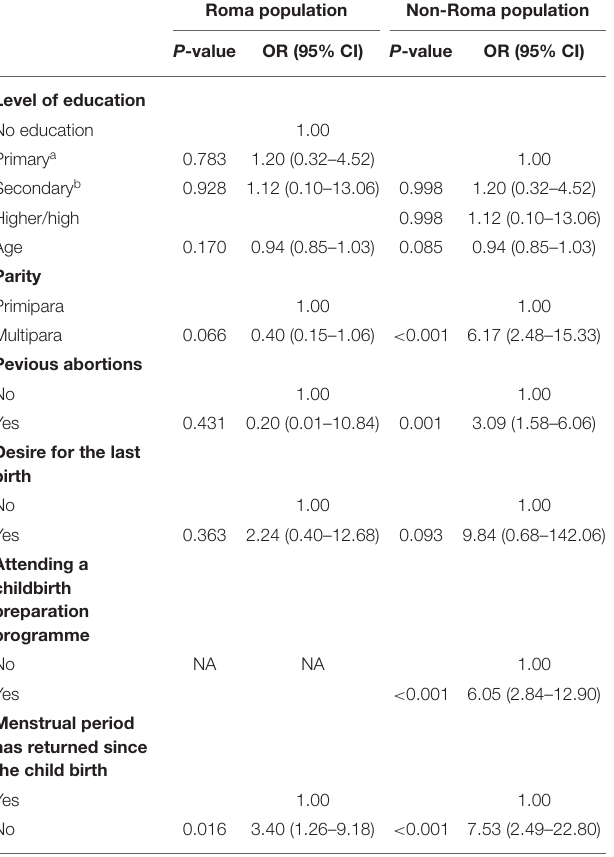
TABLE 7 | Potential predictors of exclusive breastfeeding practice during the first 6 months adjusted for mothers’ and infants’ age—final model by multivariate logistic regression